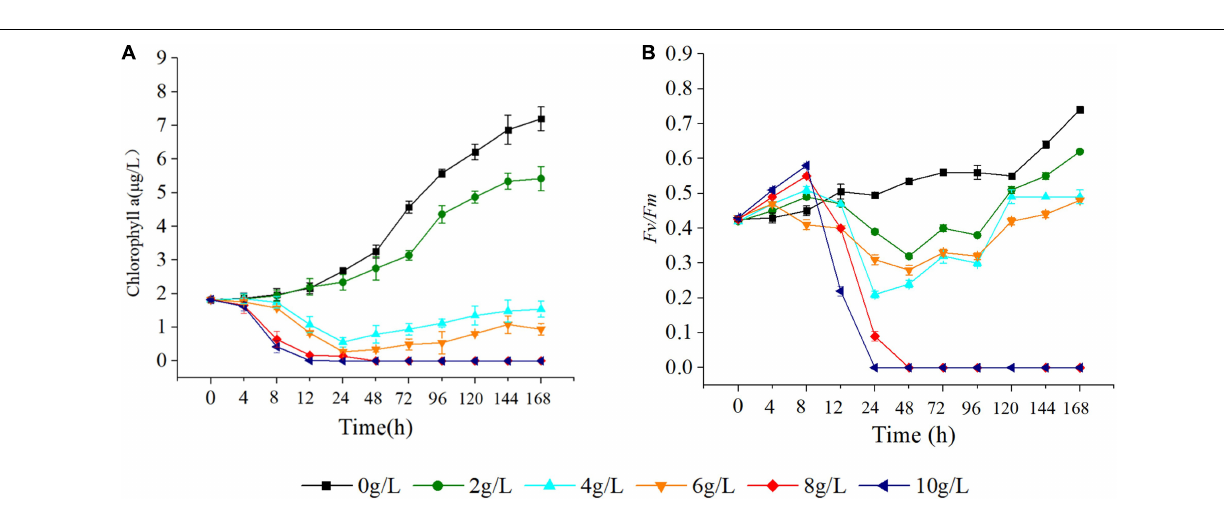
FIGURE 7 | Effect of hijiki extract on chlorophyll a content (A) and maximum quantum yield (B) of Skeletonema costatum